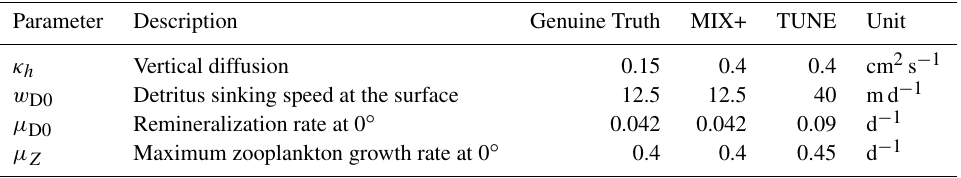
Table 1. Model parameters explored for the three model configurations used in this study (see also Table 2). The Genuine Truth configuration is identical to the one introduced by Keller et al. (2012). MIX+ and TUNE are identical to the Genuine Truth except for the differences in parameter values listed here.